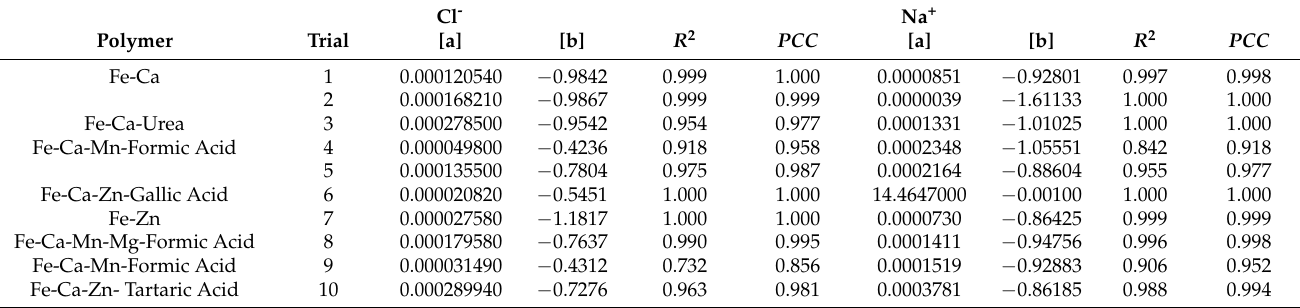
Table 1. Fe-Ca polymer.; R 2 = Coefficient of determination; PCC = Pearson’s Correlation Coefficient. All weights are g L − 1 . Data Source: Table A5 reference [20]. Trial 1. 1.4 g FeSO 4 + 3.34 g CaO;